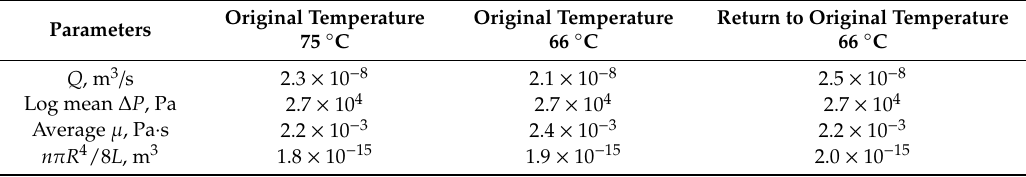
Table 8. Changes in the degree of membrane wetting when the temperature was